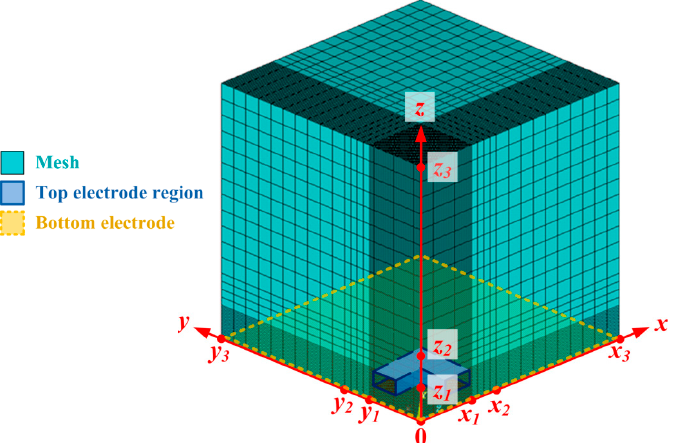
Figure 6. Scheme of ligament coefficient μ = l / pitch . l : The interval between two etching holes.